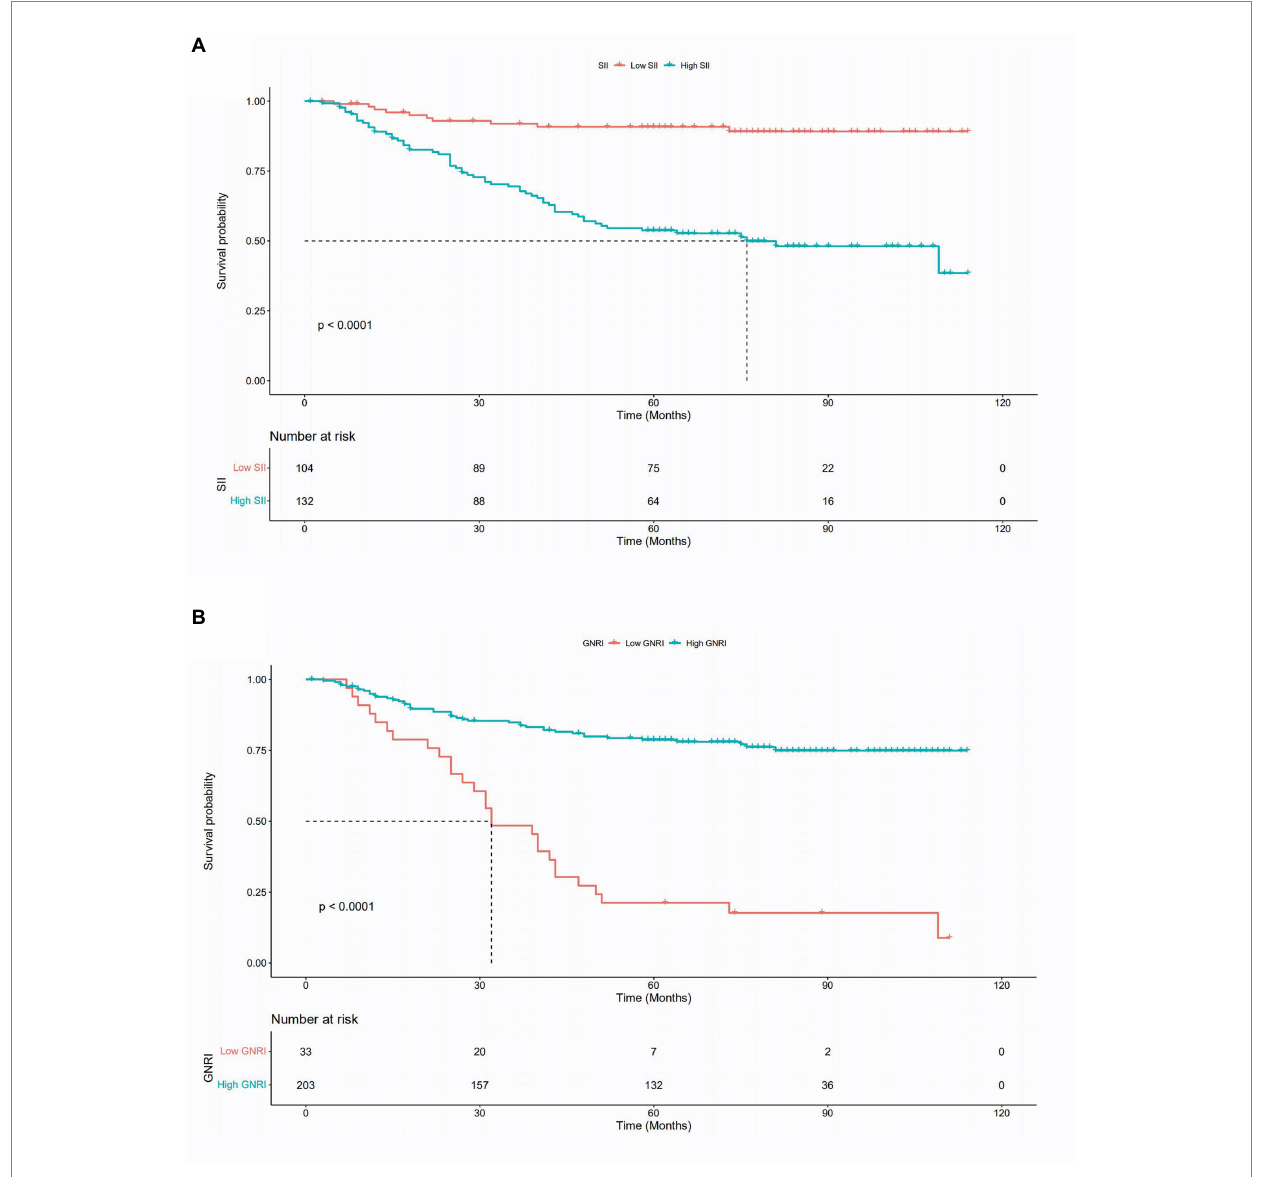
FIGURE 4 Kaplan–Meier survival curve for SII and GNRI in EOCRC. (A) SII (B)